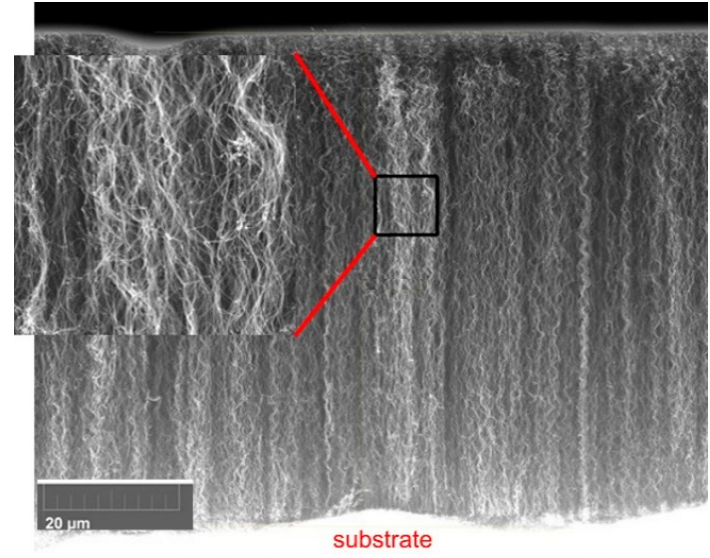
Figure 1. SEM side view on a ‘forest’ of nanotubes with a magnified view in the insert. The height of the forest is about 72 nm in this case.